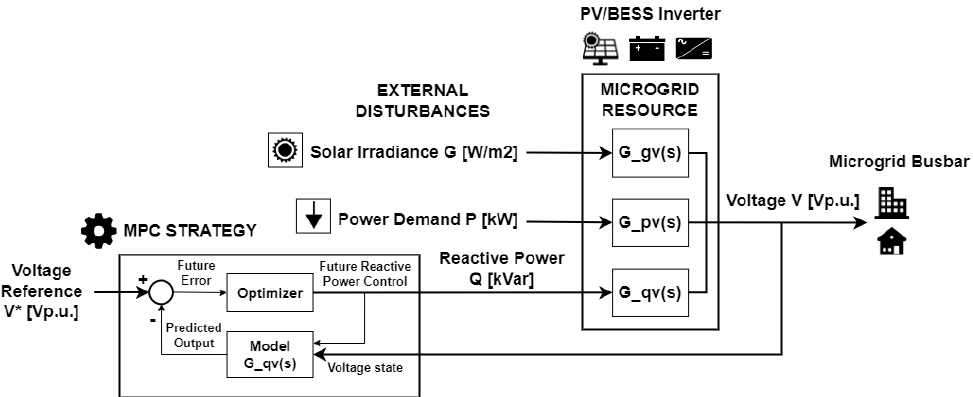
Figure 7. Basic structure of the model predictive secondary voltage